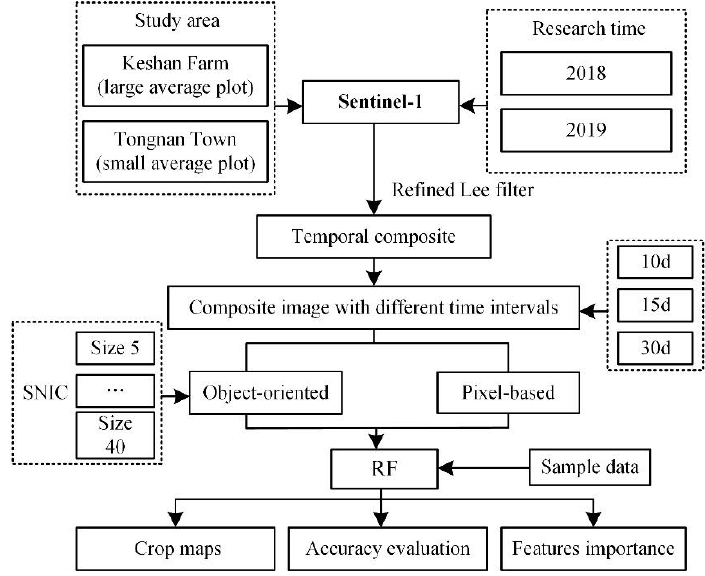
Figure 1. Flowchart.